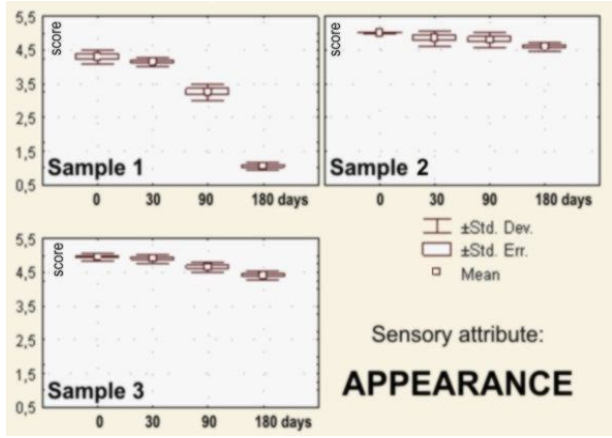
Figure 2. Box-plots for sensory attribute appearance of the filled pralines: Sample 1 —filled with honeybee drones larvae; Sample 2 —filled with the blossom honey; Sample 3 —filled with combination of blossom honey and pollen, during 180 days of